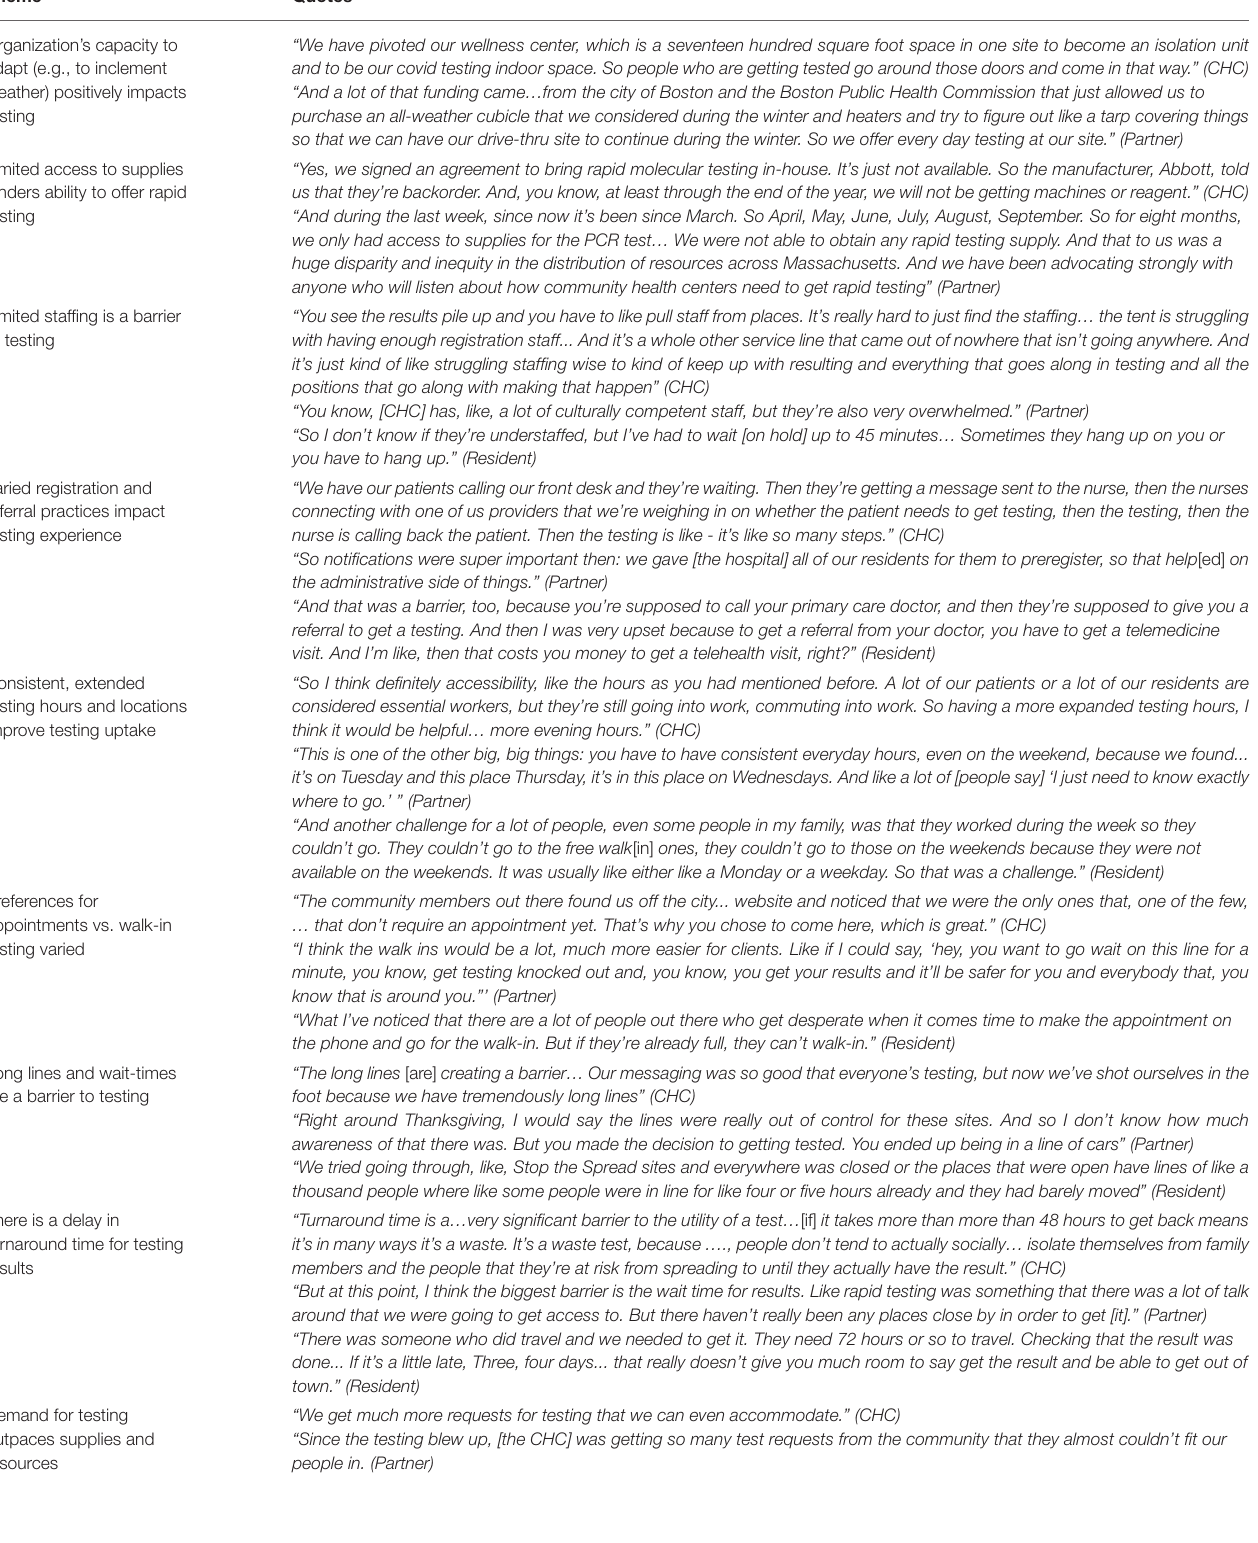
TABLE 3 | Institutional and Organizational factors influencing COVID-19 testing reported by community health center staff, partners, and residents. Theme Quotes Organization’s capacity to adapt (e.g., to inclement weather) positively impacts